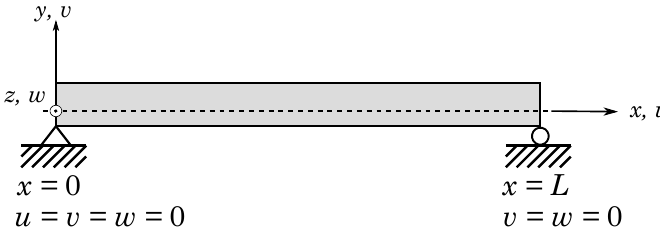
Figure 3. Boundary conditions of the solid beam. The dashed line represents the neutral fibre.